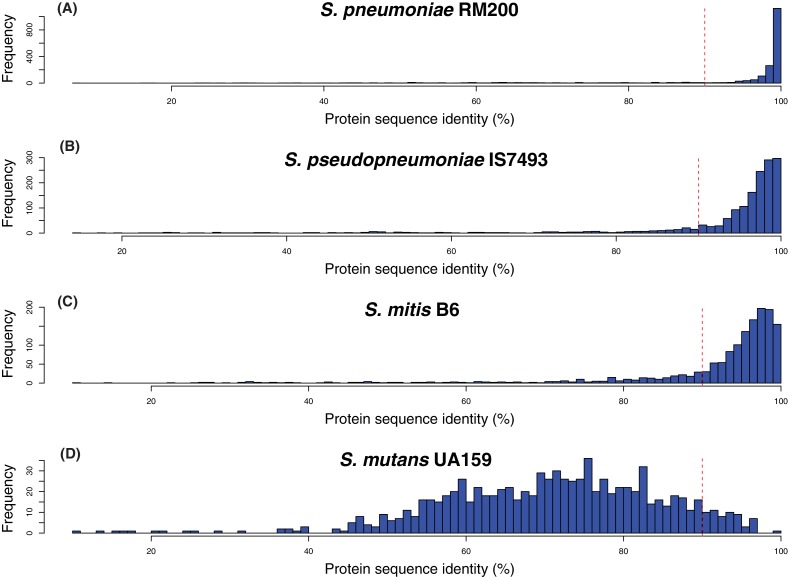
Sequence identity between proteomes of different species.Each histogram shows the pairwise protein sequence identity between the proteins on the array, and the closest orthologues in the corresponding genome. Data are shown for (A) S. pneumoniae RM200, the strain on which the vaccine is based; (B) S. pseudopneumoniae IS7493, a representative of the species most closely-related to S. pneumoniae; (C) S. mitis B6, a representative of the diverse species after which the mitis group streptococci (of which S. pneumoniae is one) is named; (D) S. mutans UA159, which was found to be too divergent for an informative analysis to be performed. The vertical red dashed line indicates the empirically-determined 90% sequence identity threshold for determining presence in, or absence from, RM200 in Figure 4A and Figure 4—figure supplement 3. Altering this threshold to 95% did not substantially alter the results presented in these figures.